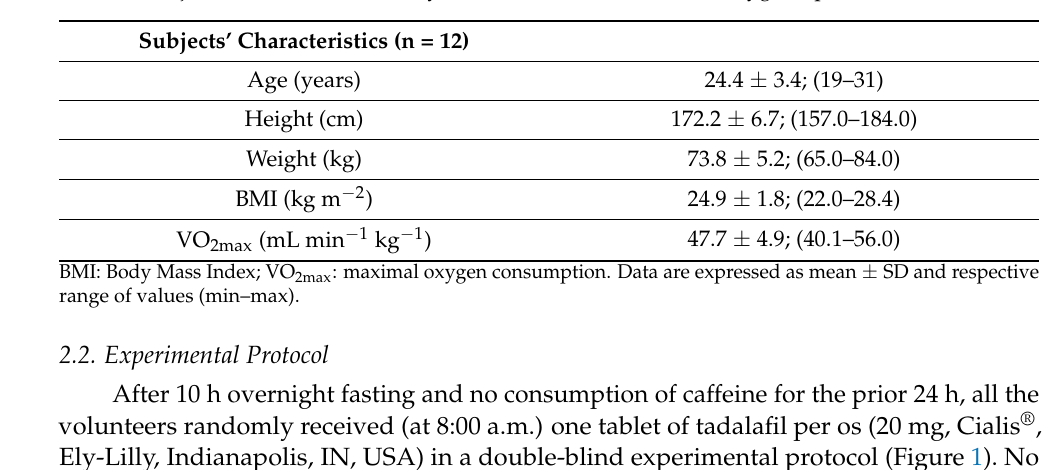
Table 1. Subjects’ characteristics: body mass index (BMI); maximal oxygen uptake (VO 2max ).